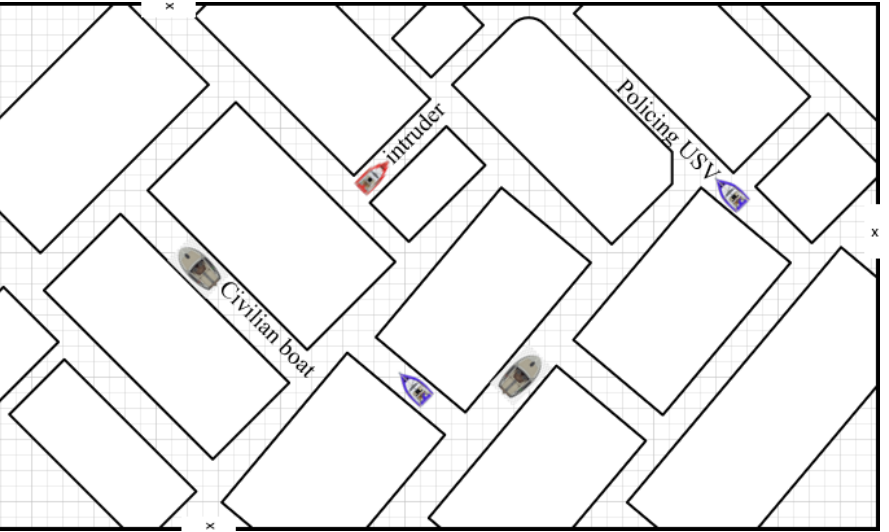
Figure 1. Example floating market or community environment map. The rectangular shapes represent floating